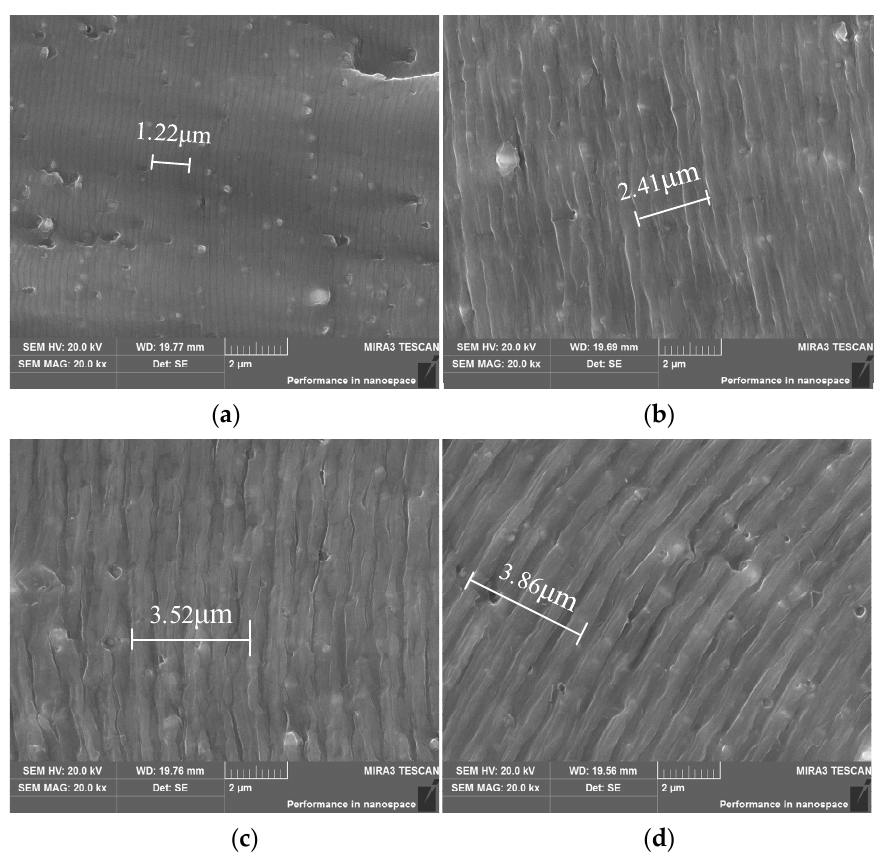
Figure 5. SEM images of fatigue striations in the stable propagation zone at different creep-aging temperatures ( a = 5 mm): ( a ) 100 °C—9 h; ( b ) 130 °C—9 h; ( c ) 160 °C—9 h; ( d ) 180 °C—9 h.